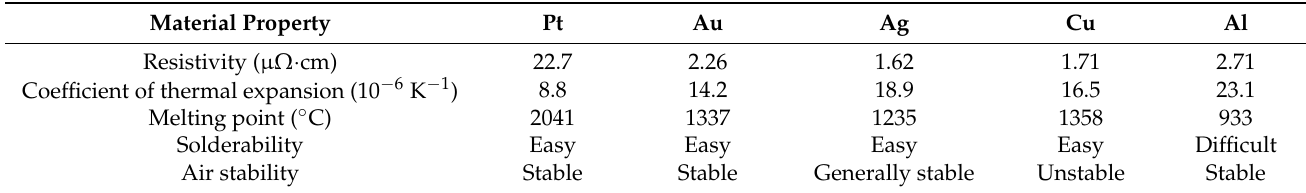
Table 2. Properties of metal